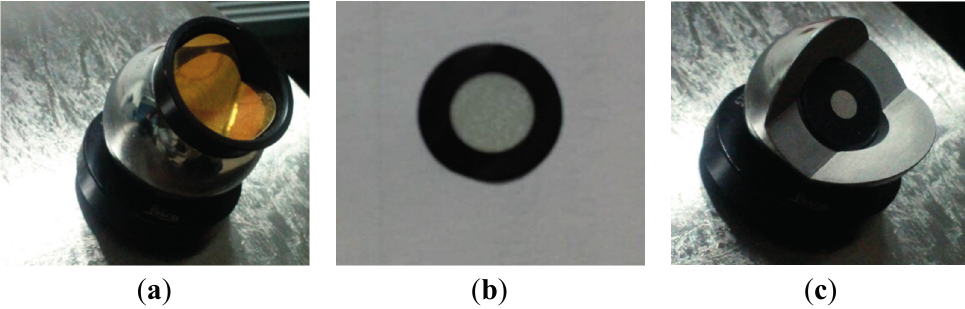
Figure 4. ( a ) TBR for the laser tracker mounted on a nest; ( b ) RRTs pasted on the object; ( c ) RRT pasted on the center of a 1.5-inch tip on the nest to assess the same point with the laser tracker and